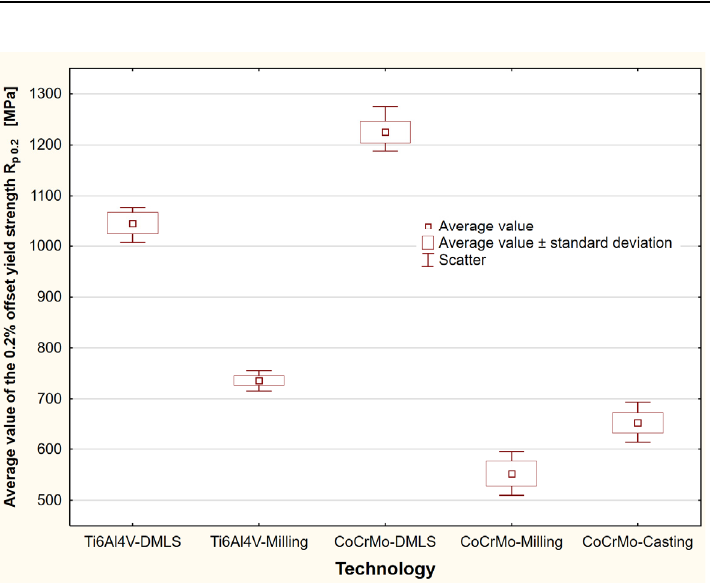
Figure 3. Compressive strength test: ( a ) test node during loading; ( b ) CoCrMo alloy sample from DMLS after the compression test.